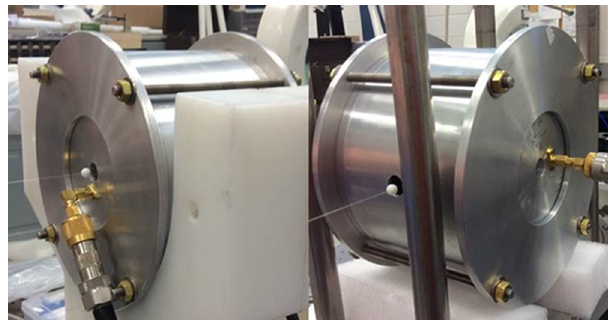
FIG. 20. Result of the measurement with the dielectric (top) and the metallic (bottom) bead, and the comparison with simulation